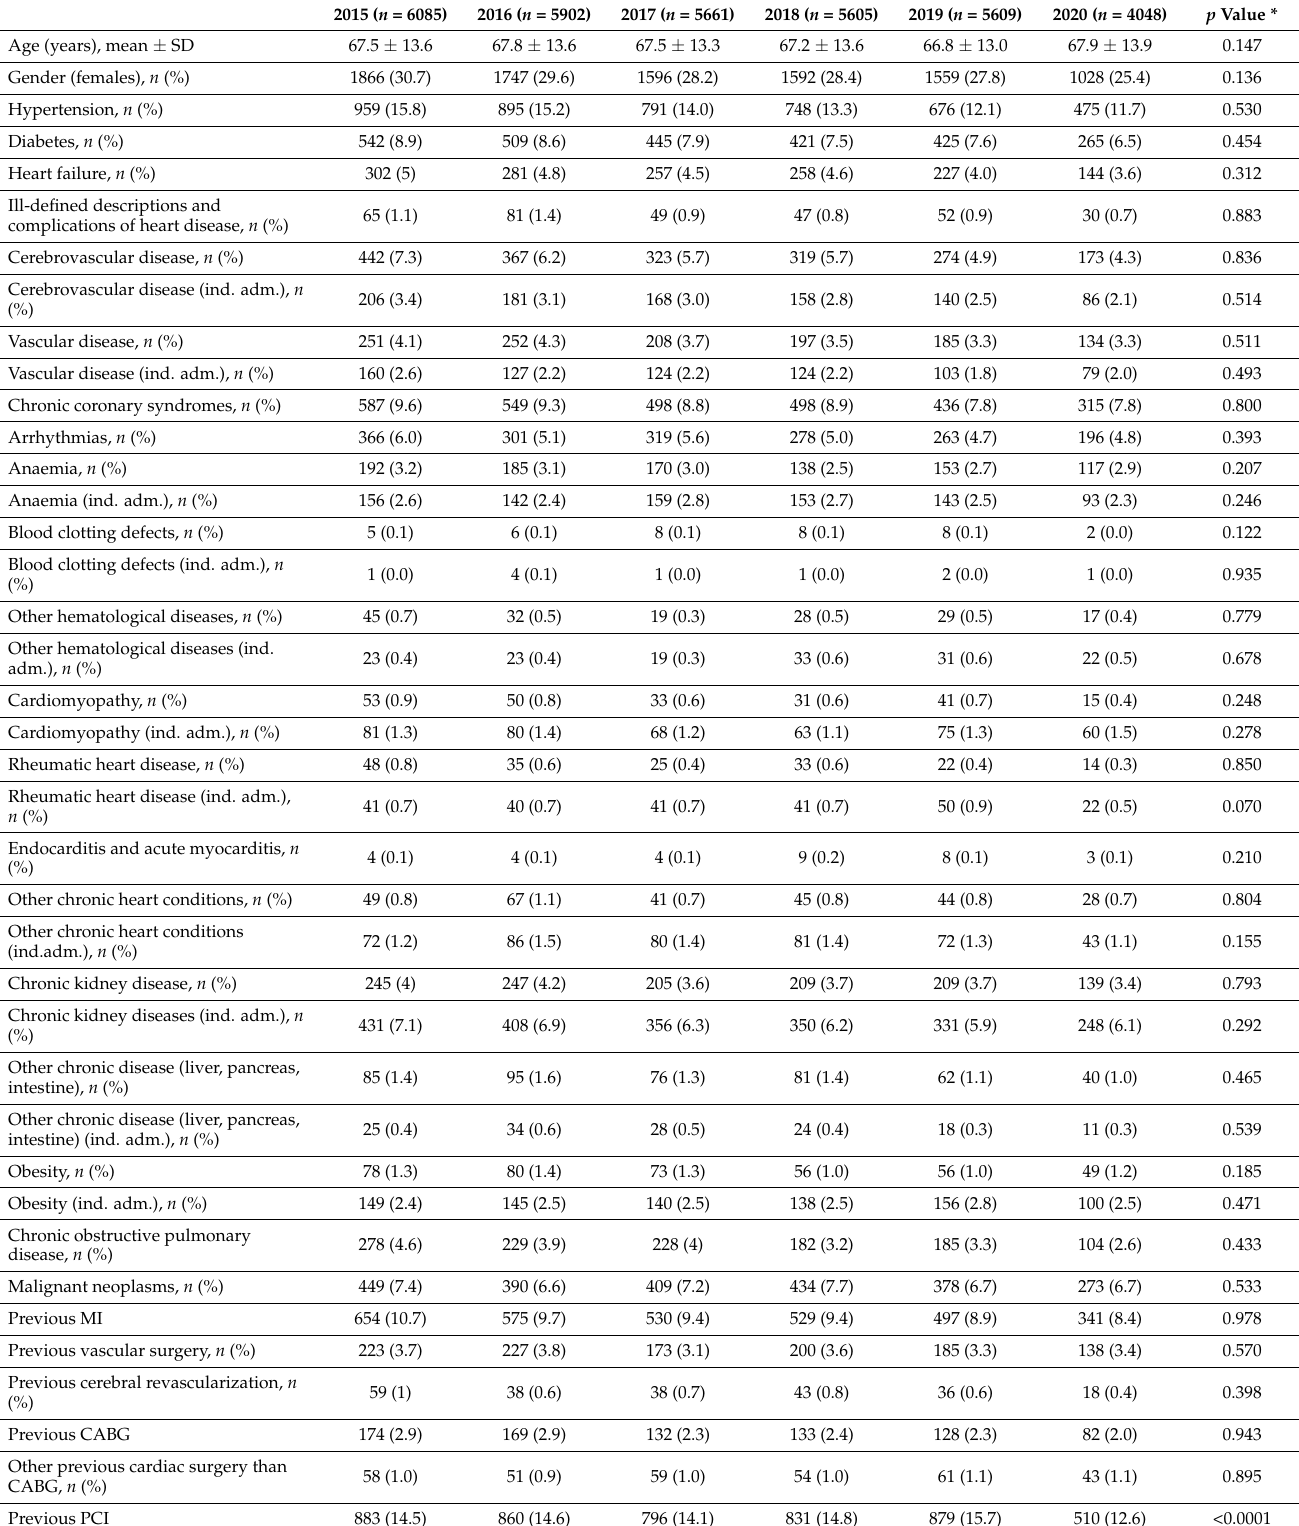
Table 1. Baseline characteristics of the enlisted population by